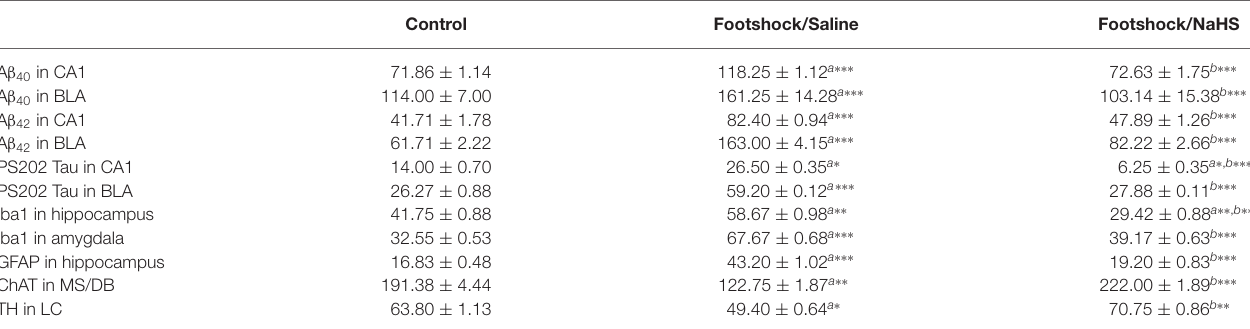
TABLE 2 | Immunohistochemistry results for mice receiving different treatments. Control Footshock/Saline